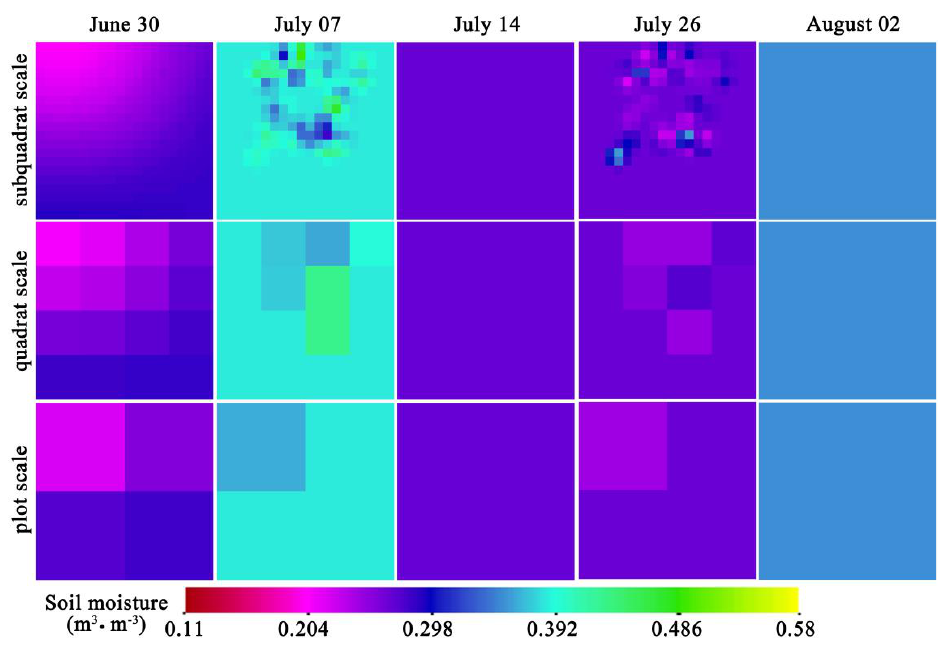
Figure 7. Upscaled soil moisture estimations at the scale series by ordinary kriging on five acquisition days.